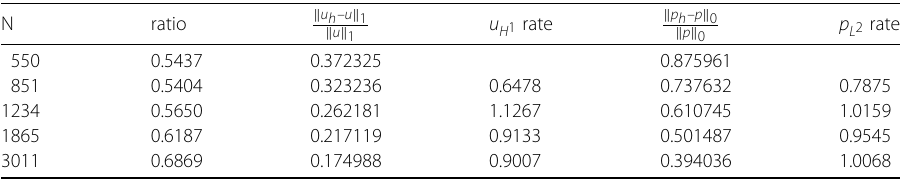
Table 1 Errors and the effective index on adaptive meshes with ν = 1